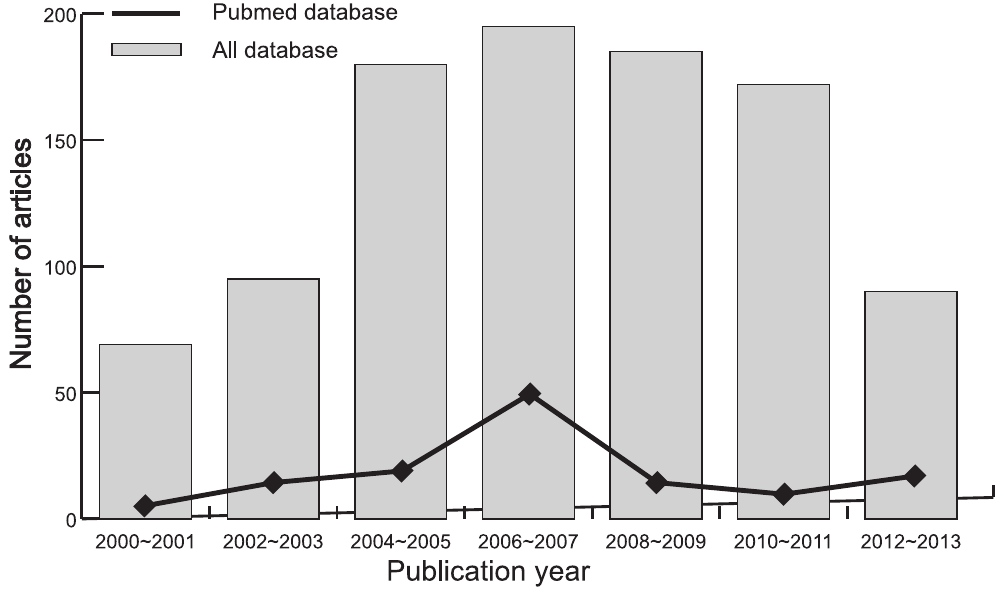
Figure 2. The distribution of the number of topic-related literatures in the electronic database during the last decade.